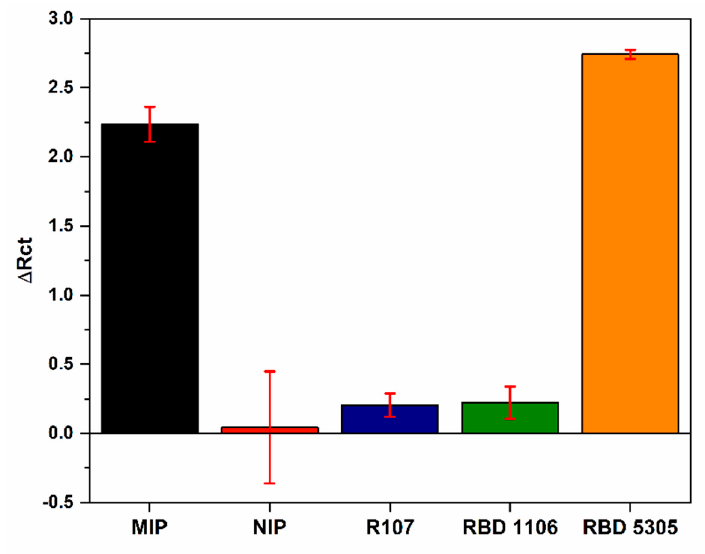
Figure 5. Response of the BioS after incubation with SARS-CoV-2 spike glycoprotein. The analytical signal is herein represented as a relative increase in charge ‐ transfer resistance ( Δ R ct ).